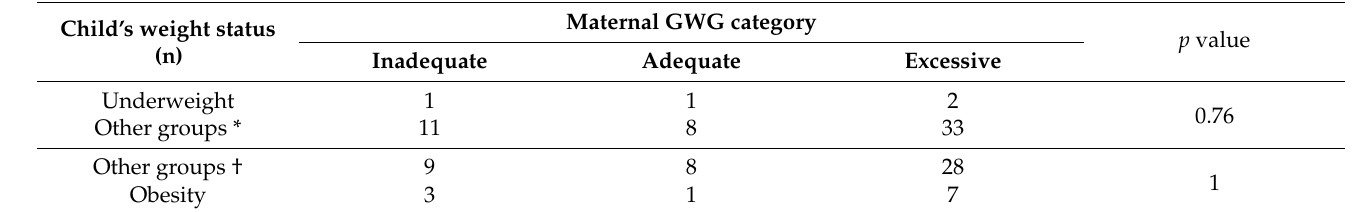
Classification by centile charts: BMI-for-age, 24